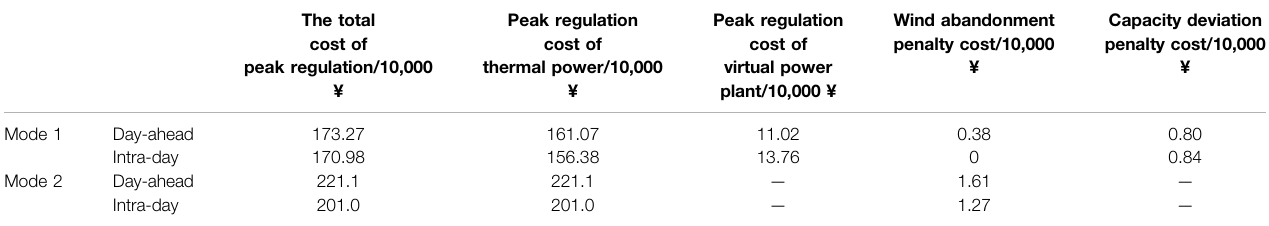
TABLE 3 | System peak regulation cost.